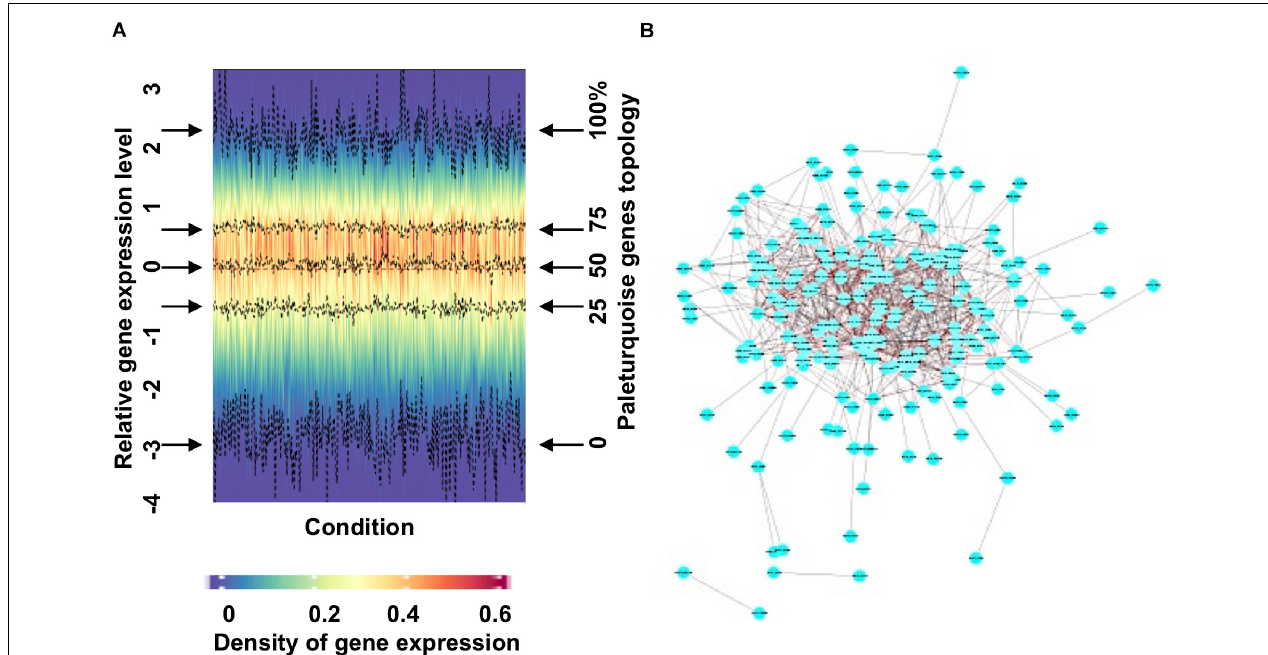
FIGURE 2 | Visualization and analysis of an exemplar PhaeoNet merged module (paleturquoise). (A) Density heatmap of all genes assigned to the paleturquoise merged module. The y-coordinate positions in the graph relate to density distribution of gene expression in each sample (shown on the left y -axis); the four middle dashed lines (indicated by horizontal arrows on either side of the graph) correspond to the median, first and third quantiles (shown on the right y -axis). The majority of the genes in this specific module show limited variation in expression profiles over different conditions samples. (B) A topological representation of connectedness within the paleturquoise merged module, visualized with Cytoscape (version 3.6.1). Each node represents a gene. Edges represent pairwise correlations between genes. The network shows all the paleturquoise module genes with a correlation value over a threshold of